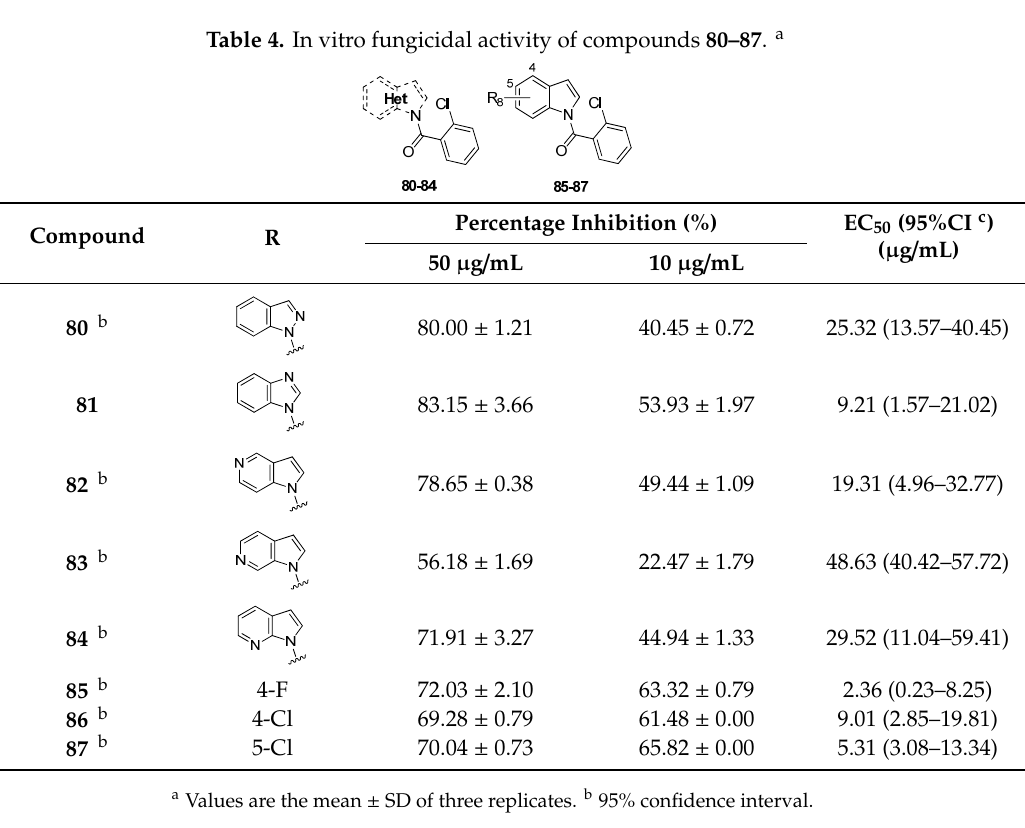
Table 4. In vitro fungicidal activity of compounds 80 – 87 . a.